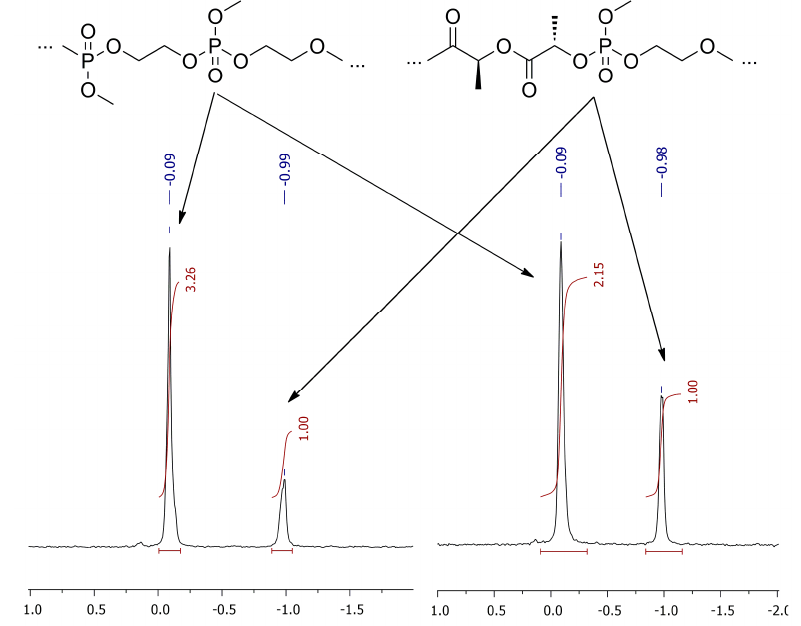
Figure 4. The 31 P NMR spectra of L -LA/MeOEP copolymers (Table 3, runs 3a and 3b).